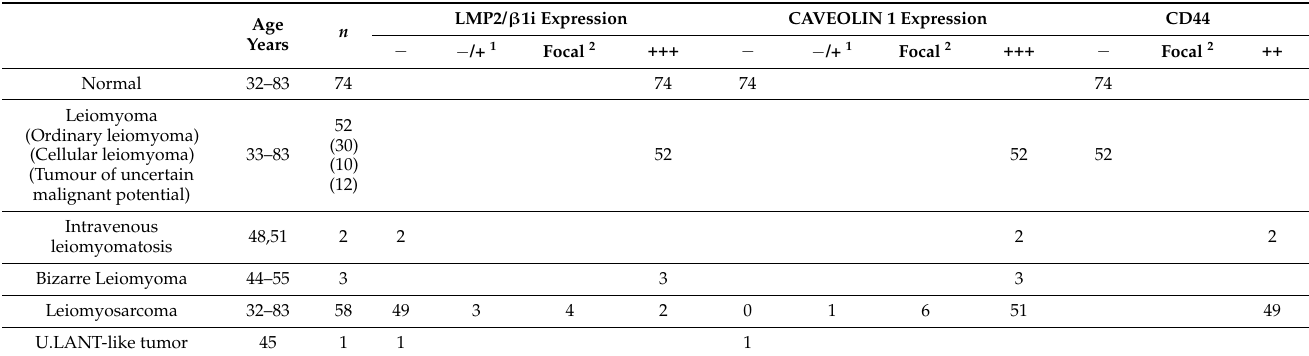
Table 1. Differential expressions of PSMB9/ β 1i, CALPONIN h1 and CD44 in human uterine mesenchymal tumors and uterine LANT-like